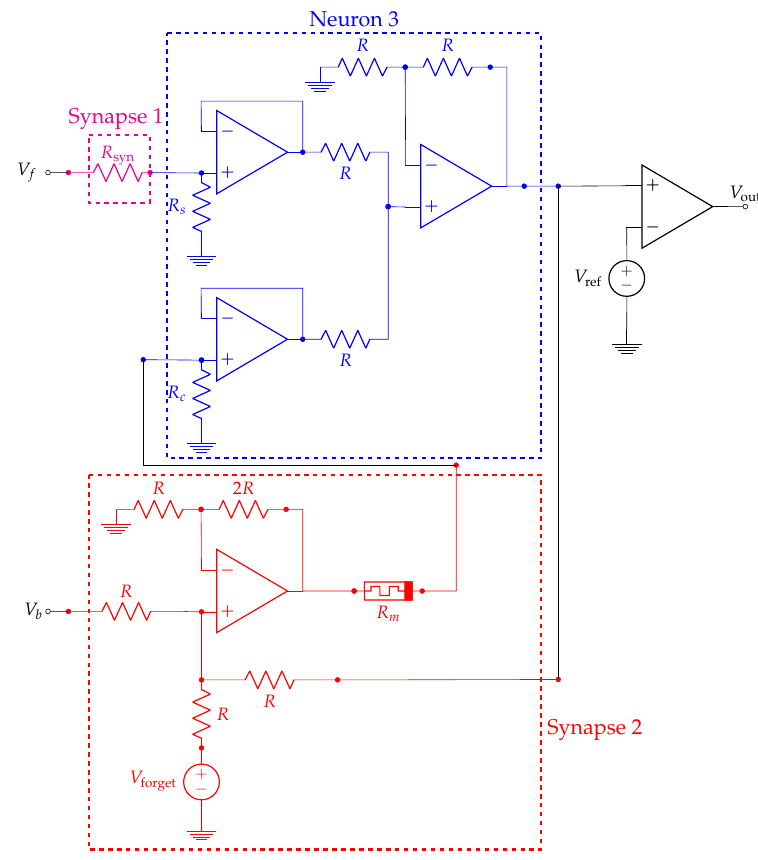
Figure 14. Circuit schematic of the system used to mimic Pavlovian learning. Only the output of the input neurons is represented: V f is the response of neuron 1 to the unconditioned stimulus (i.e., food) and V b is the response of neuron 2 to the conditioned stimulus (i.e., bell’s sound)—cf. Figure 3. Resistance values: R = 3.3 k Ω , R syn = 220 Ω , R s = 2.2 k Ω and R c = 2 k Ω . Constant voltages: V forget = 600 mV, V ref = 232